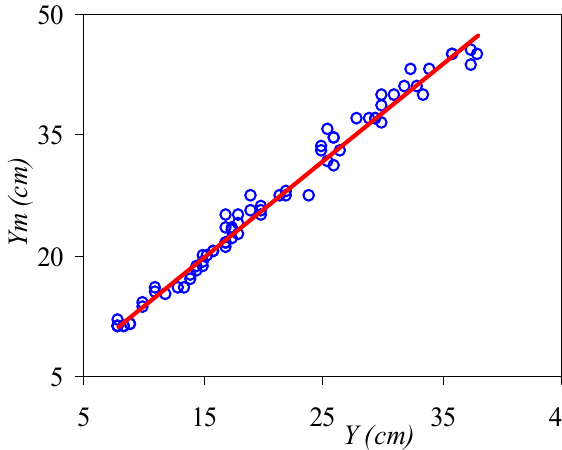
Figure 3. Relationship between maximum level of jet centerline ( Y ) and maximum edge ) for all experimental cases. level ( Y m